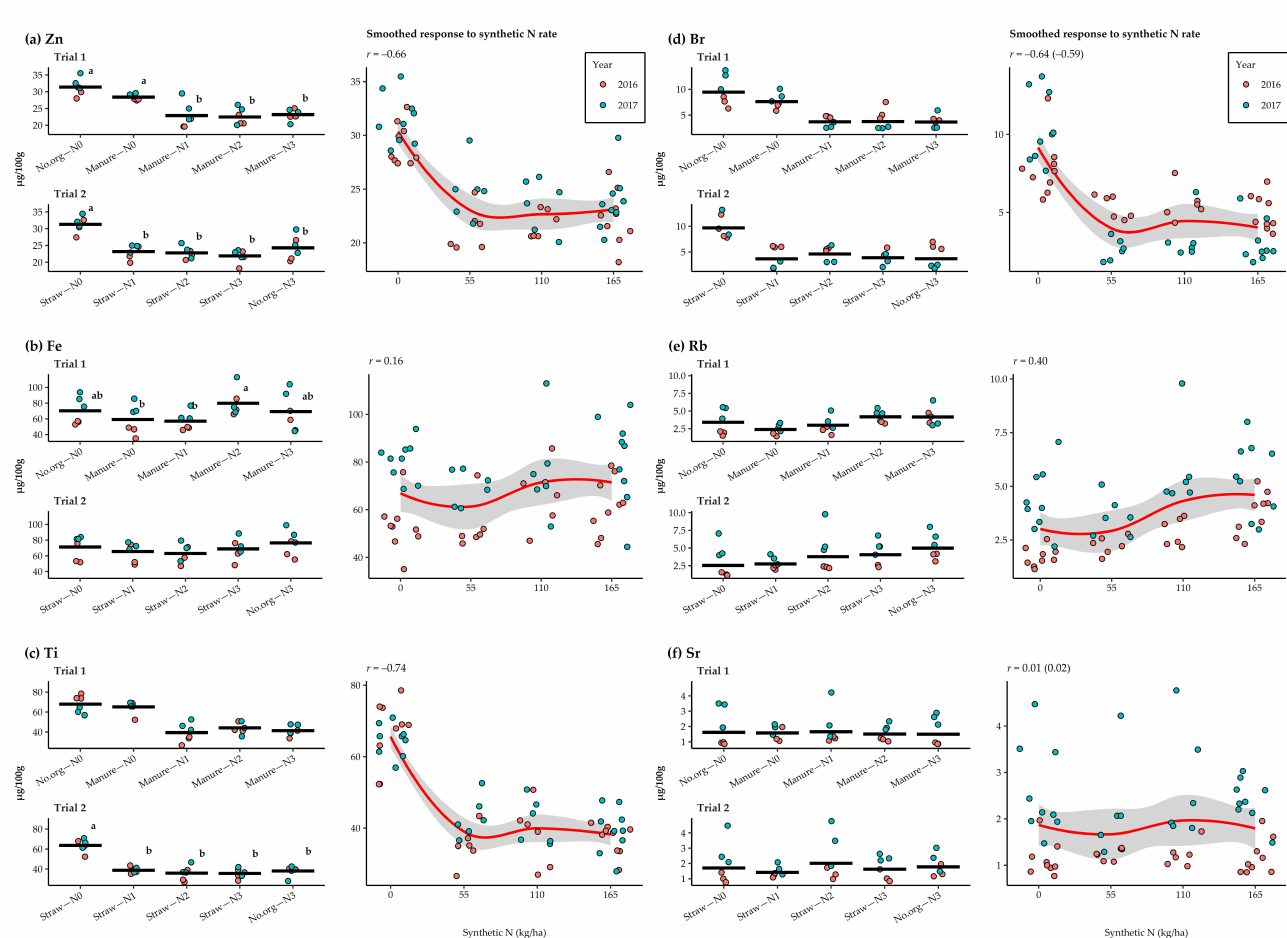
Figure 3. Response of microelements ( a – f ) in oat grains to N rates and agronomic management practices applied in a long-term field experiment in 2016–2017. The crossbar indicates the mean value, while the dots represent individual observations. Means marked with different letters represent significant differences according to Tukey’s HSD test ( α = 0.05) within each trial. The smoothed conditional means method (Loes method) represents the overall observed response of the selected variables to the synthetic N rate and the correlation coefficient. When the data was transformed in both trials, the “ r ” value in brackets indicates the correlation coefficient for the transformed